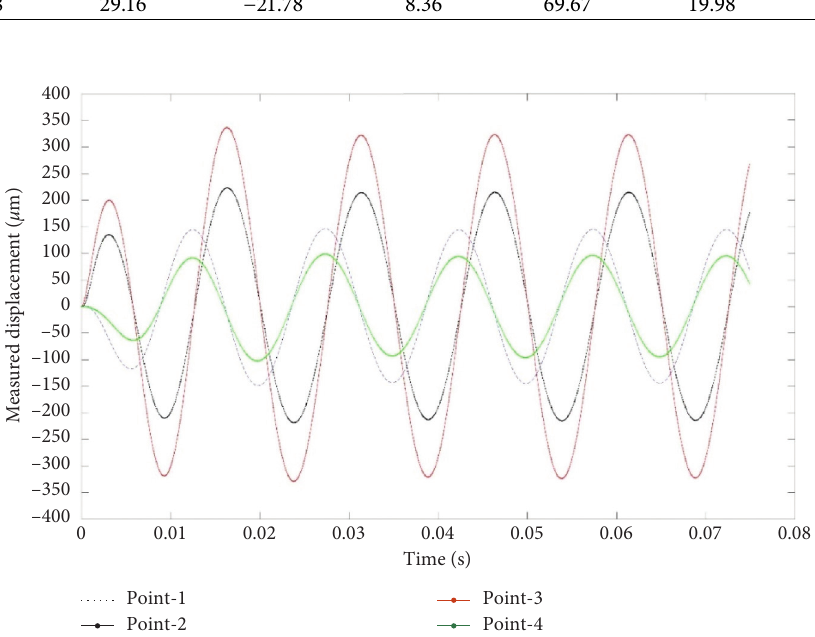
Figure 3: The structural response at four observed